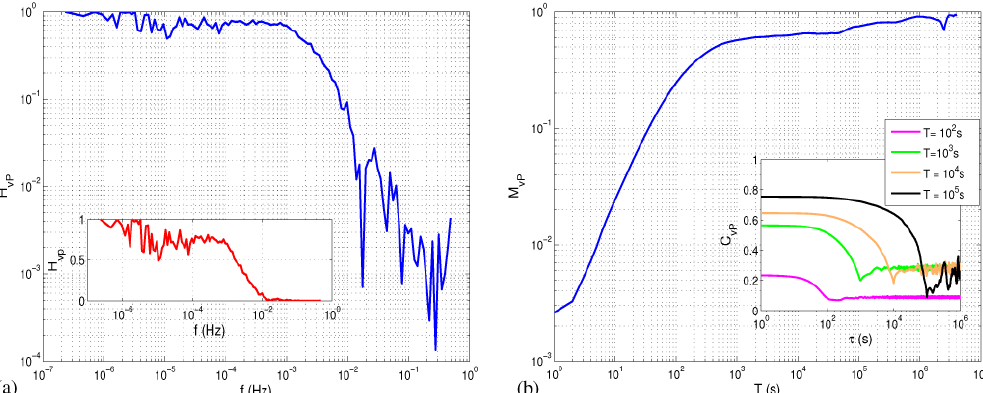
Fig. 7. The coherence function H vP (frequency domain) (a) and the maximum M vP (time domain) (b) of the cross-correlation function C vP in log–log plot for the simultaneous wind speed/power data: the insets in (a) shows the functions H vP in semilogx plot, and the inset in (b) shows the cross-correlations for the simultaneous wind speed/power output moving averages, computed for timescales T = 10 2 , 10 3 , 10 4 , and 10 5 s.